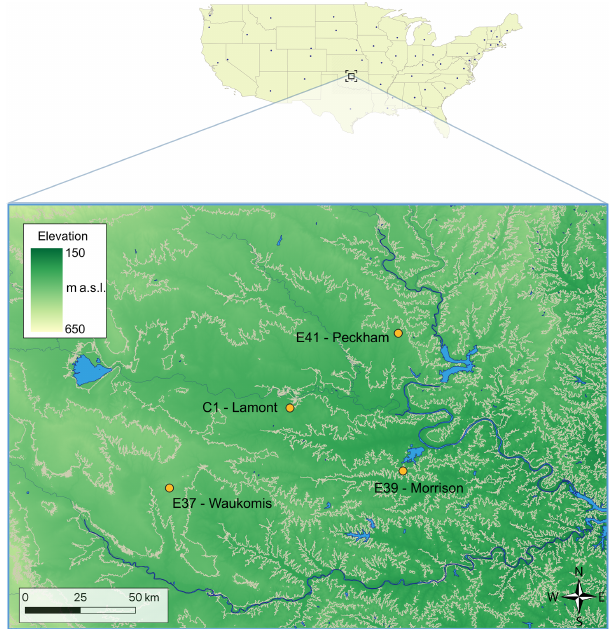
Figure 1. Map of the four sites at the Southern Great Plains atmo- spheric observatory considered in this study. Contour lines at 50m intervals are shown in the map. Digital elevation model data cour- tesy of the U.S. Geological Survey.